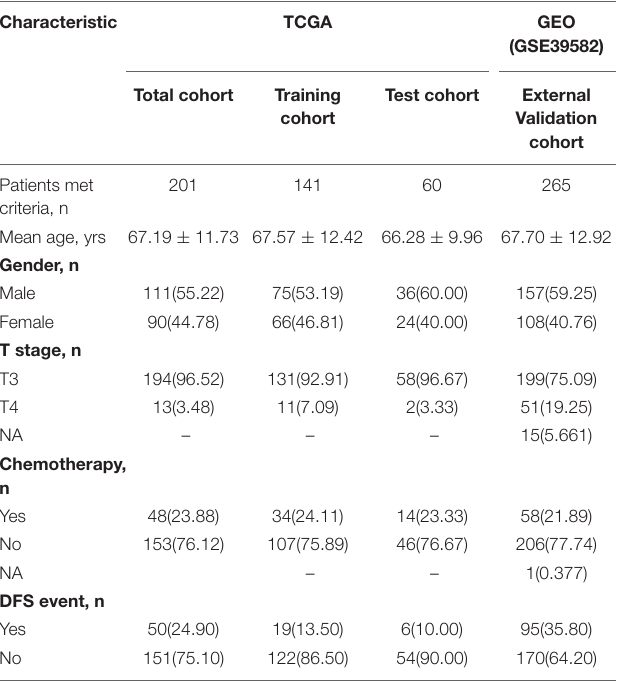
TABLE 2 | Patient demographics and clinical